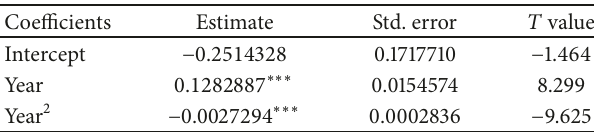
Table 7: Time series regression analysis for 1950–1999.